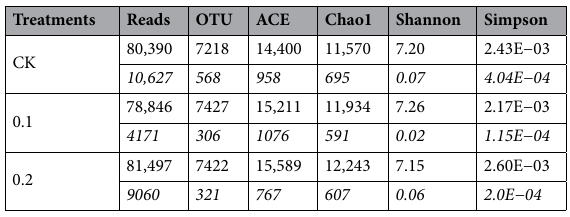
Table 3. Alpha diversity of bacterial communities in rhizosphere soil treated with 5 mg/kg Cd under different S fertilization treatments. Italic number indicates the standard deviation.